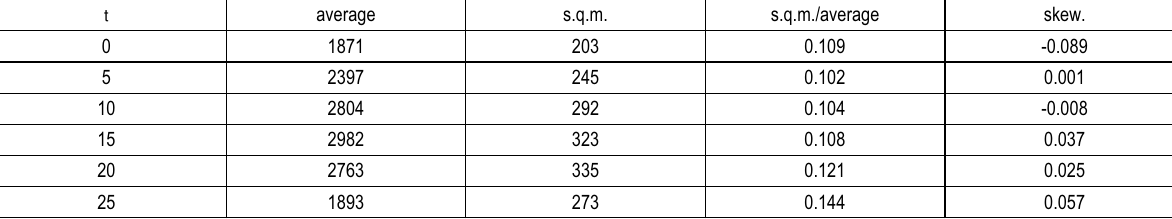
(cid:5) U evidenced for the standard stochasticity level, excluding contract escapes t